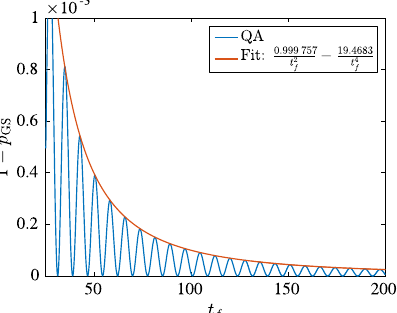
FIG. 11. Ground-state probability for a single qubit for different total time t , evolving under the plain Hamming weight f Hamiltonian in Eq.